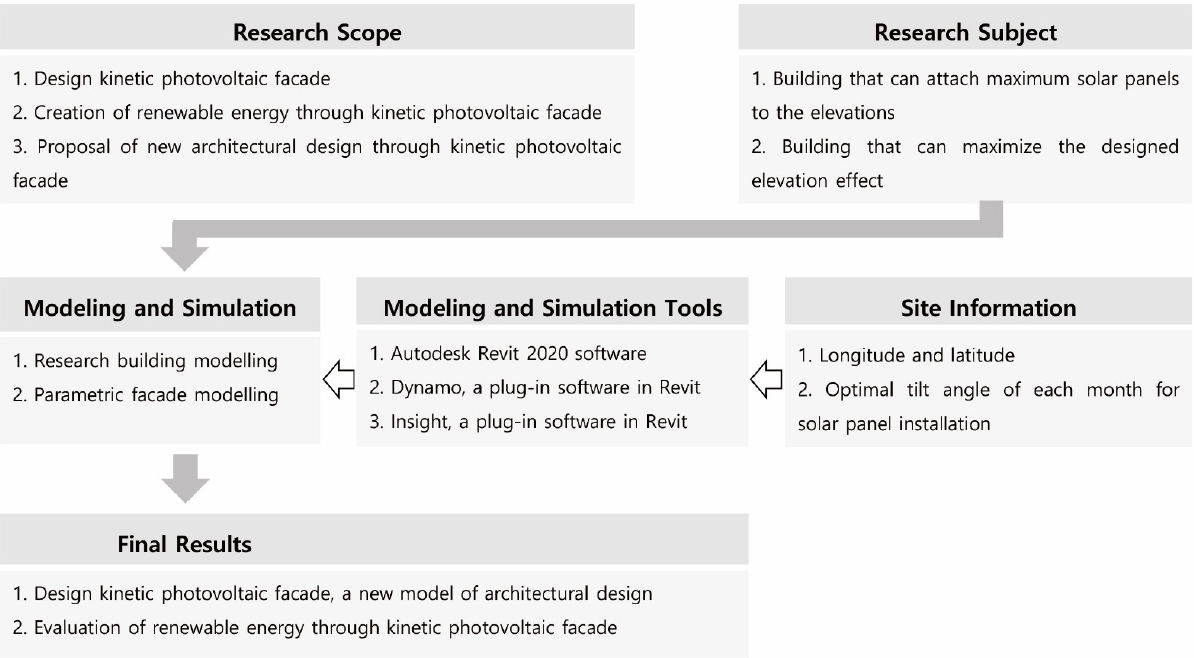
Figure 1. Processes in the proposed method.